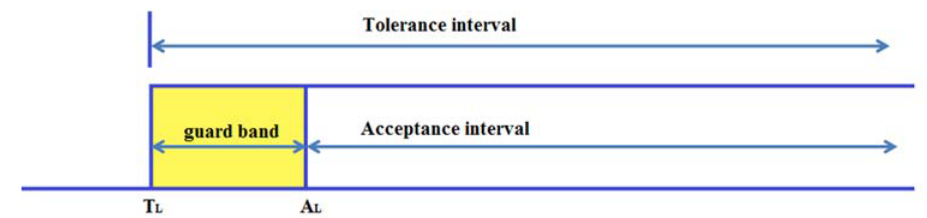
Figure 1. Acceptance and tolerance interval [32].